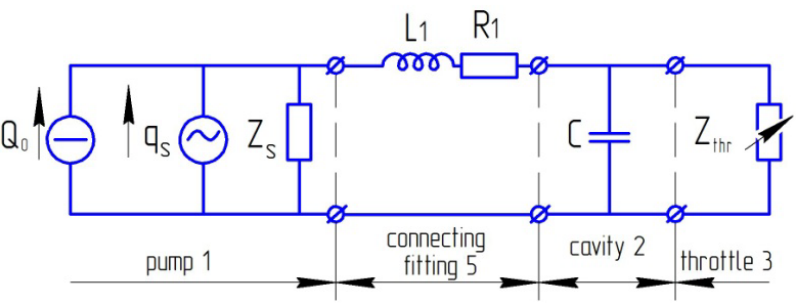
—throttle impedance. Z thr